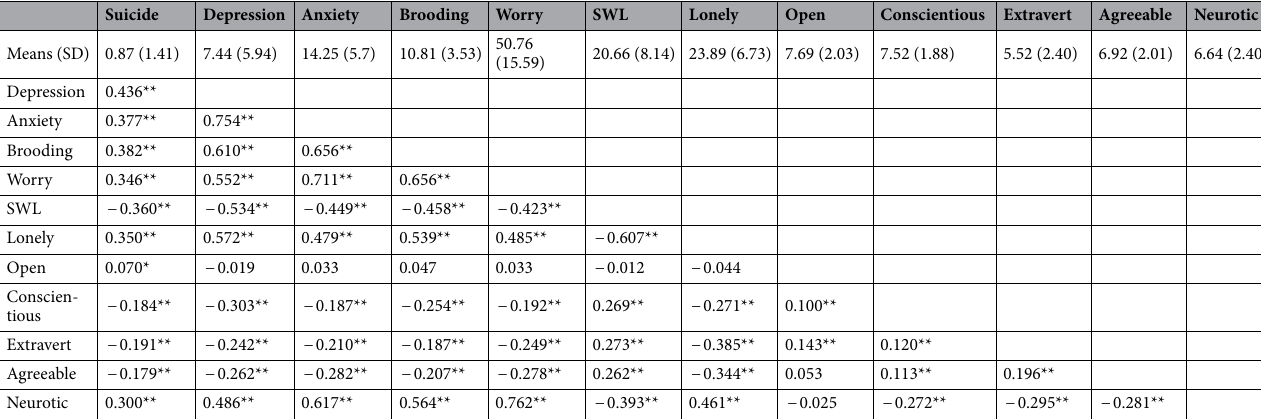
Table 1. Descriptive statistics and correlations of the psycho-diagnostic measures ( N = 1650). Notice that the current research addressed low satisfaction with life whereas the SWL is formulated in a positive manner (i.e., high satisfaction with life). This positive formulation explains the negative correlation between SWL and depression. Suicide the total score of the CSSRS, SWL satisfaction with life scale. **p < 0.01.